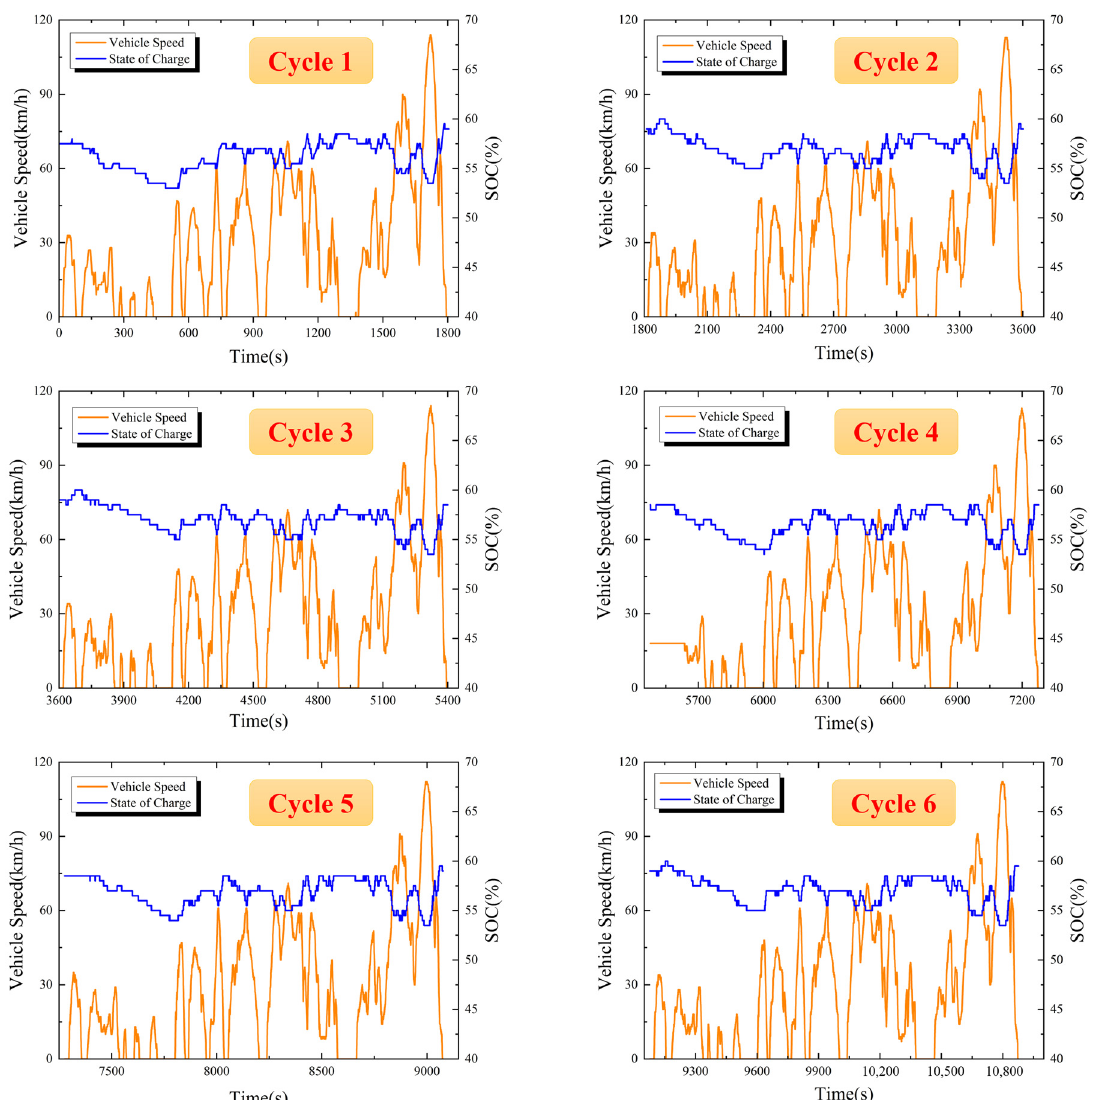
Figure 9. Operating characteristics of vehicle A under six continuous CLTC-P